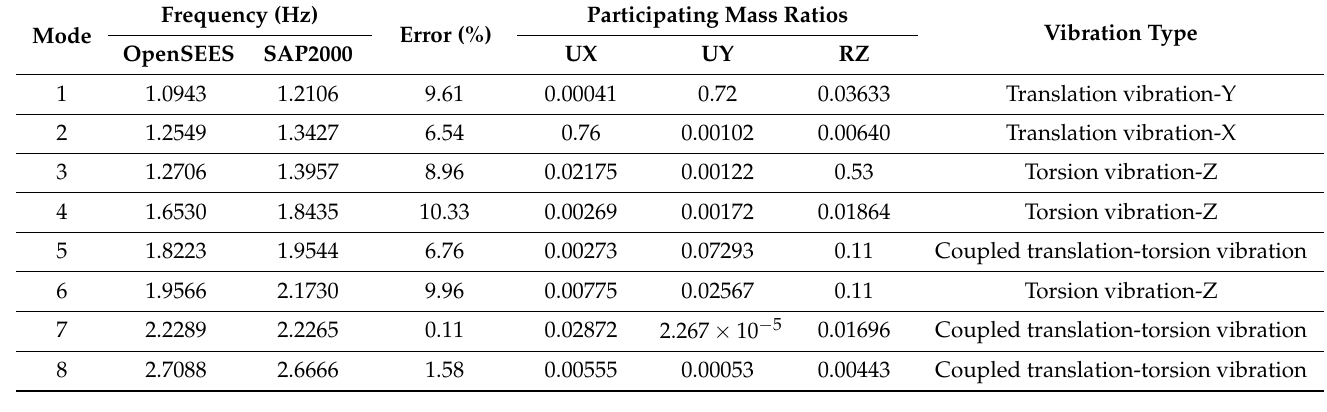
Table 1. Comparisons of modal analysis results from OpenSEES and SAP2000.